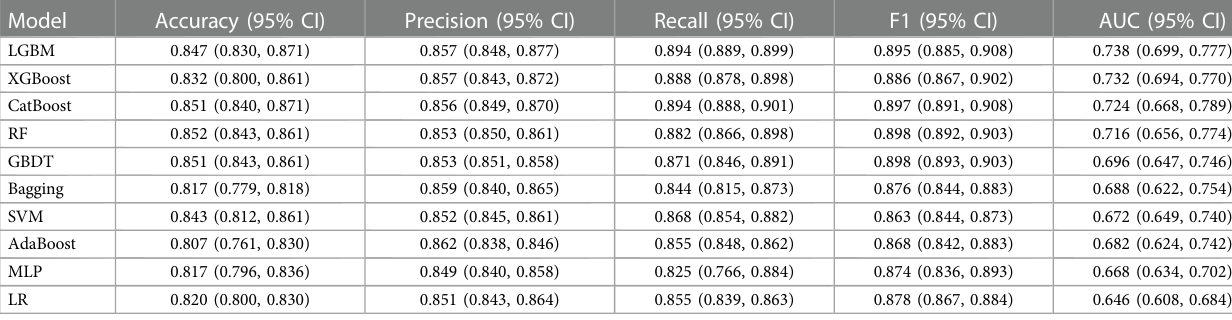
TABLE 3 Performance summary of machine learning models in Non-CMP-IV group.